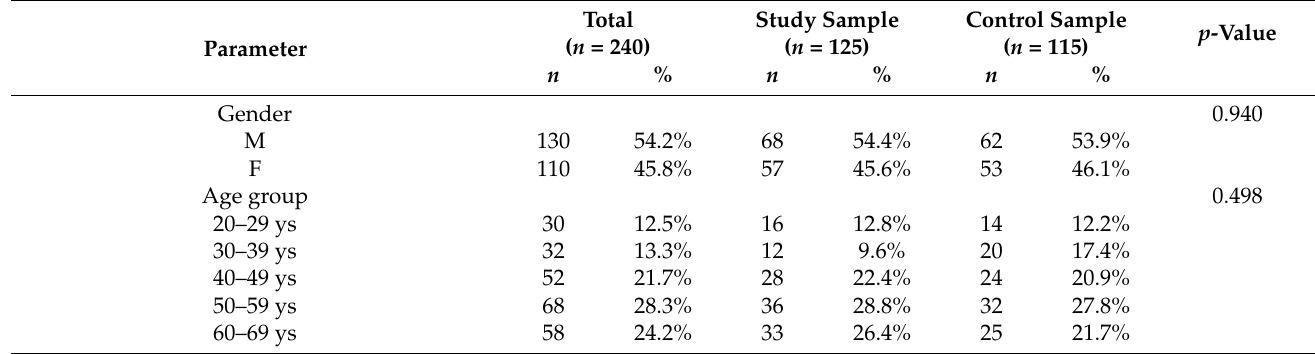
Table 1. Demographic and clinical parameters of the